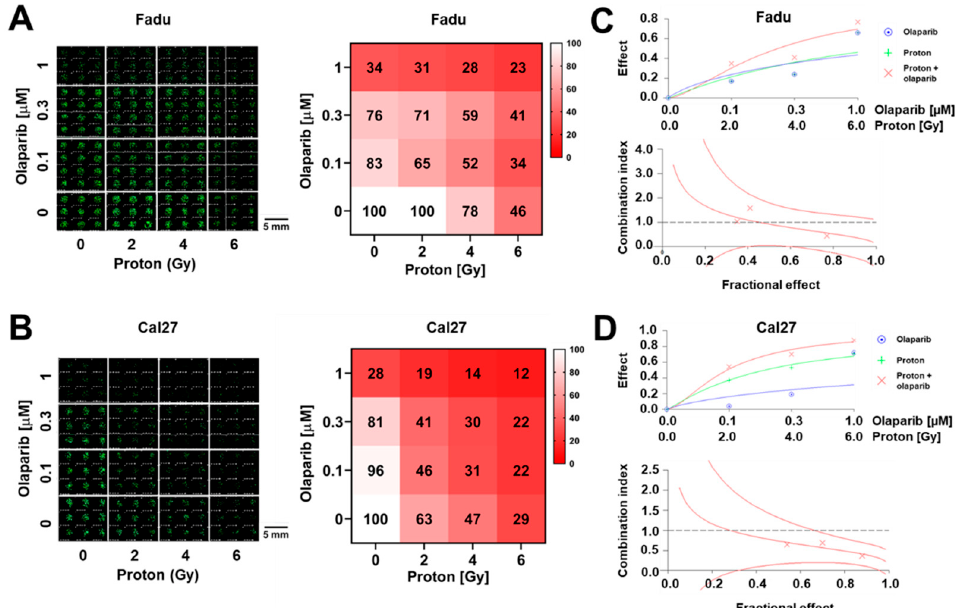
Figure 5. Measurement of the combination effect of proton and olaparib on the growth of HNSCC spheroids using the 3D-based HTS platform. ( A , B ) Sensitivity of Fadu ( A ) and Cal27 ( B ) spheroids to combination therapy with proton and olaparib. Left, fluorescence images of 384-pillar/well plates containing Fadu and Cal27 spheroids treated with indicated doses of protons and olaparib. Right, 4 × 4 matrices showing survival rates of Fadu and Cal27 spheroids for different combination treatment conditions. Color scale represents relative survival rates. ( C , D ) Combination index (CI) values of Fadu ( C ) and Cal27 ( D ) at indicated doses of proton and olaparib. Top, dose–effect curves. Bottom, CI values calculated by CalcuSyn software (Biosoft, Ferguson, MO, USA). The X-marks represent the CI values of the combination treatment groups. The middle curve line represents the simulated CI values of the combination treatment groups surrounded by two lines of algebraic estimations of the 95% confidence intervals.